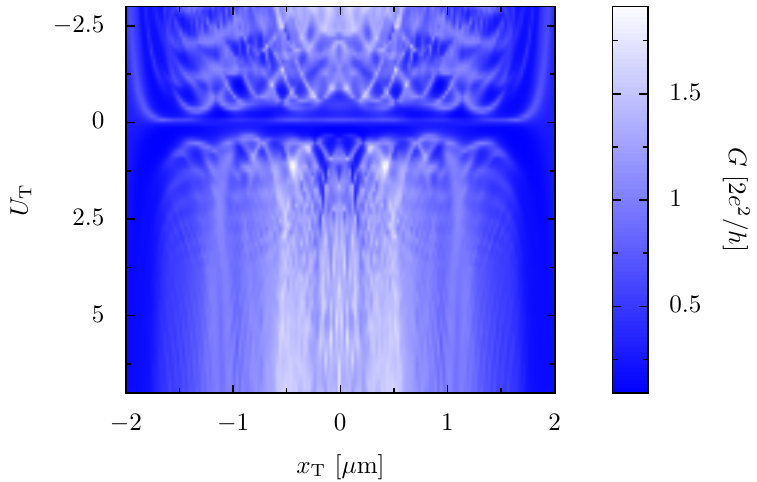
Figure 10: Quantum conductance (in colorscale) through the model cavity in the absence of disorder, as a function of tip position x (dimensionless) tip strength U